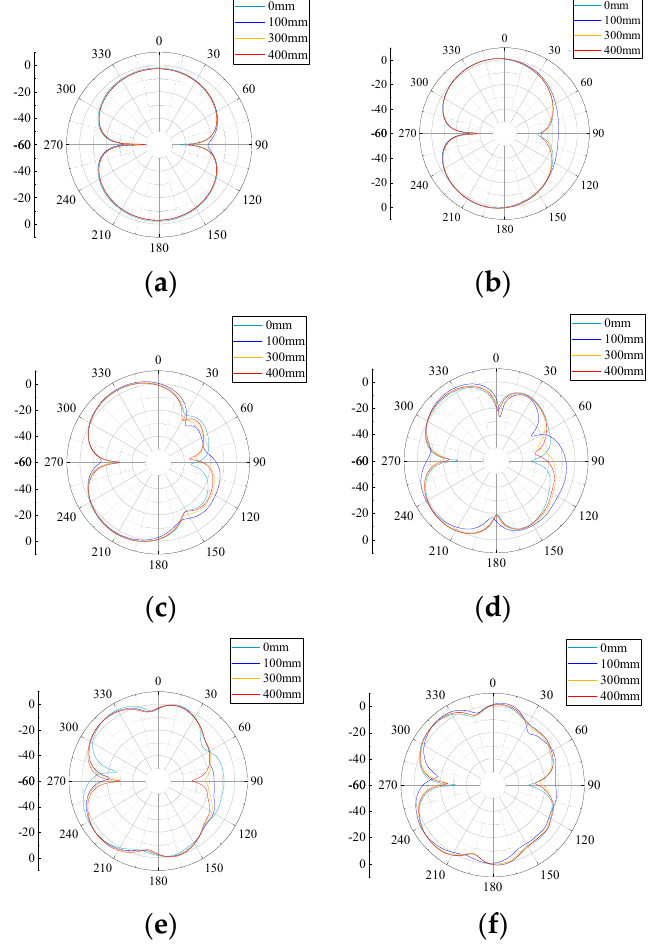
Figure 11. H-plane patterns at different frequencies: ( a ) 0.5 GHz; ( b ) 1 GHz; ( c ) 1.5 GHz; ( d ) 2 GHz; ( e ) 2.5 GHz; and ( f ) 3 GHz.